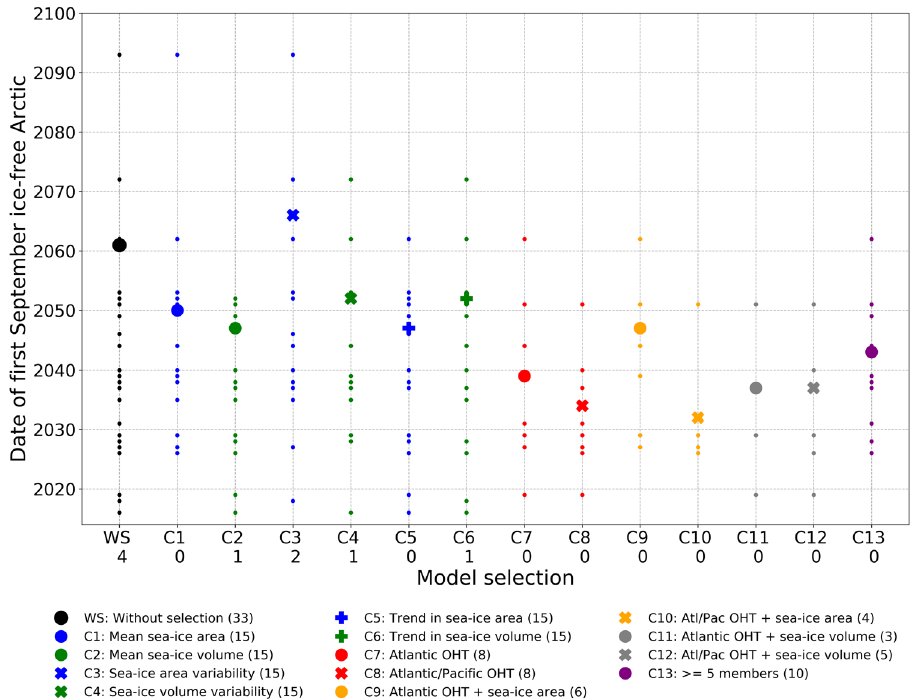
Fig. 4 Date of fi rst September ice-free Arctic. The date of fi rst ice-free Arctic is de fi ned as the year when September sea-ice area drops below 1 million km 2 for the fi rst time, for the different selection criteria (C1 – C13) and without selection (WS), based on the SSP5-8.5 scenario. The big symbols show the dates of the multi-model means, while the small dots show the dates of the models included in each criterion. The number of models that do not reach ice- free conditions before the end of the century is indicated below X labels. The number of models included in each multi-model average is indicated in parenthesis in the